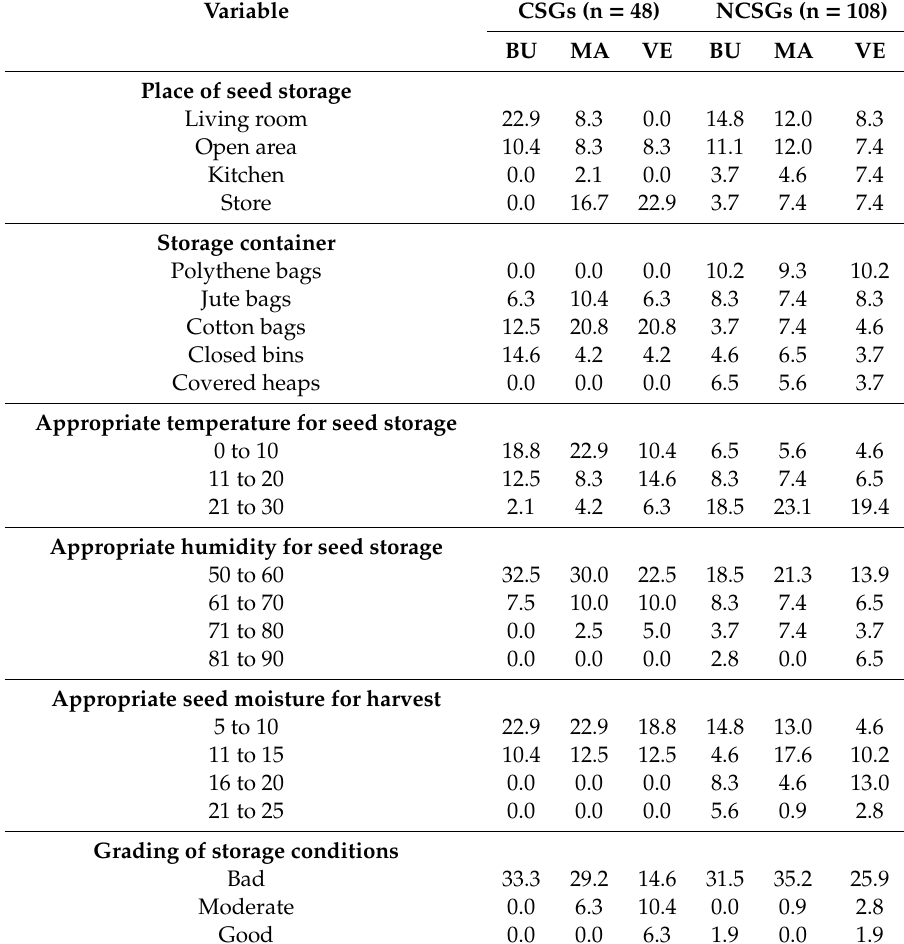
Table 2. Farmers’ practices and knowledge of seed